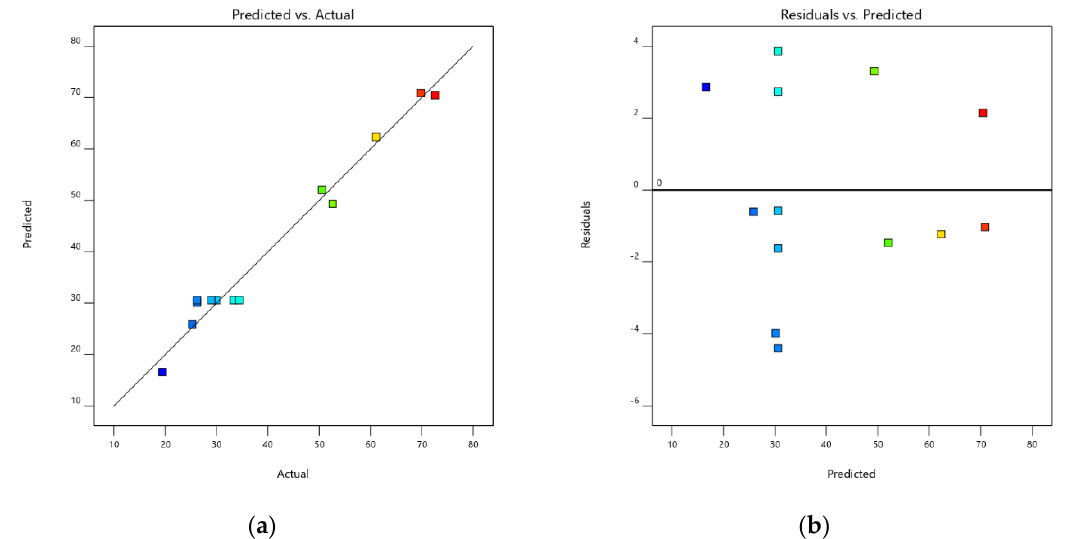
Figure 3. Graph plotted between the predicted and actual degree of esterification (DE) ( a ) and plot of the residuals versus the predicted DE of de-esterified pectin sample ( b ). Table 4. Analysis of variance (ANOVA) for the quadratic model.